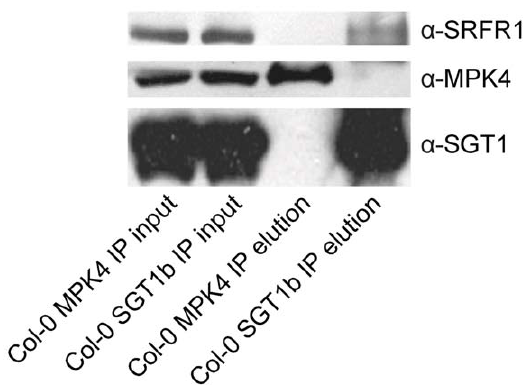
Figure 5. SGT1 associates with SRFR1 inplanta . Co-IP of SGT1 with SRFR1 in total protein extracts from wild type Col-0 plants. Protein extracts were subjected to immunoprecipitation with anti-SGT1b or anti-MPK4 agarose beads. Crude lysates (left panels, Input) and immunoprecipitated proteins (right panels) were detected with Anti- SRFR1, anti-SGT1 or anti-MPK4 antibodies.